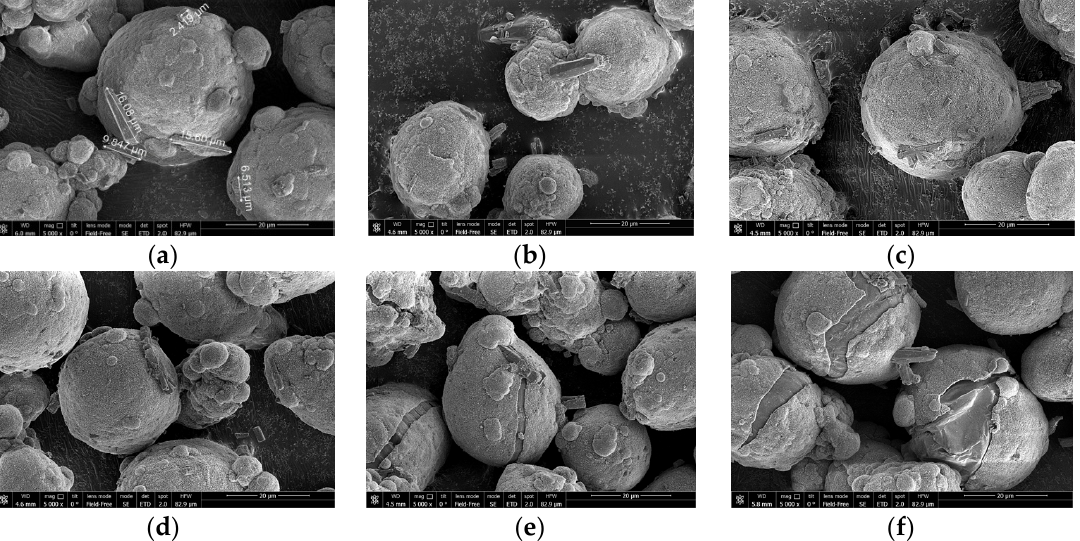
Figure 5. Micrographs of different samples of partially oxidized aluminum powder: ( a ) sample after drying at 120 °C; ( b ) sample after thermal treatment at 200 °C; ( c ) sample after thermal treatment at 300 °C; ( d ) sample after thermal treatment at 400 °C; ( e ) sample after thermal treatment at 500 °C; ( f ) sample after thermal treatment at 600 °C.